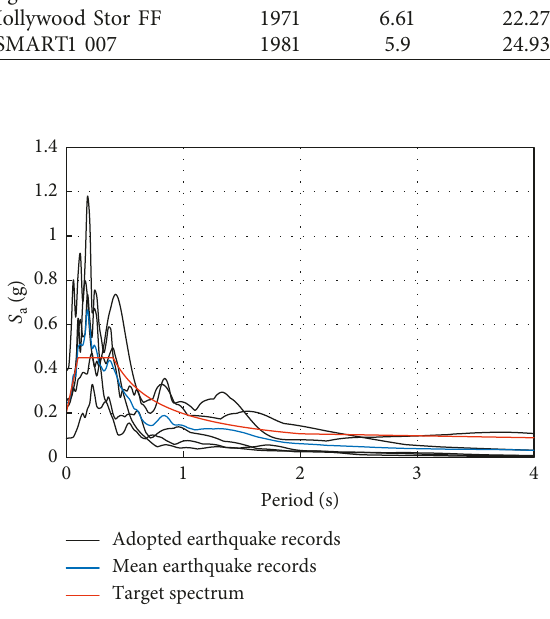
Figure 4: Response spectra of the selected input seismic ground motions.